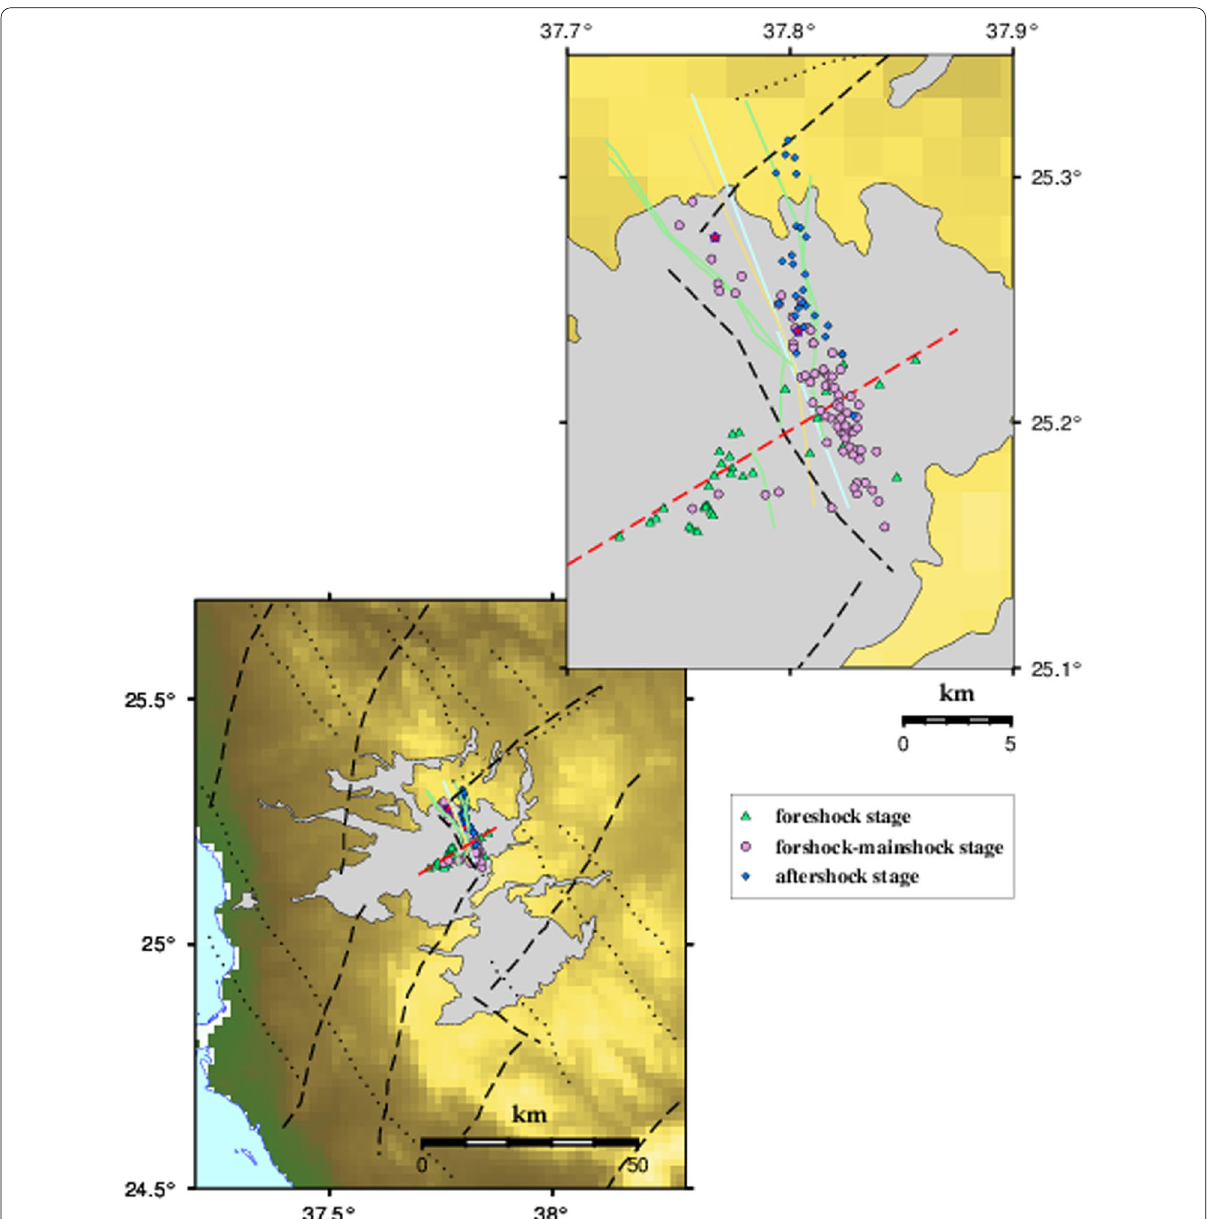
Fig. 8 Structural map showing gravity trends (thick dashed lines) interpreted as inherited Precambrian faults, aeromagnetic trends (thin dotted lines) related to Cenozoic dykes, normal faults evidence by InSAR (Baer and Hamiel 2010) (green lines), and Harrat area represented by a grey polygon. The map also shows the spatial distribution of relocated epicenters for the events listed in Additional file 1: Table S1. The 2009 HL seismic activity was described as a swarm-like earthquake sequence with a pattern that began with a swarm activity denoted by the events 1–35 (triangles) that delineated the NE fault trend; the foreshock–mainshock stage represents the events 36–109 (circles) that are located over the NNW fault trend and the aftershock stage represents the events 110–136 (diamonds) that distributed over the NNW fault trend. The red dashed line represents the fault trends identified from the distribution of